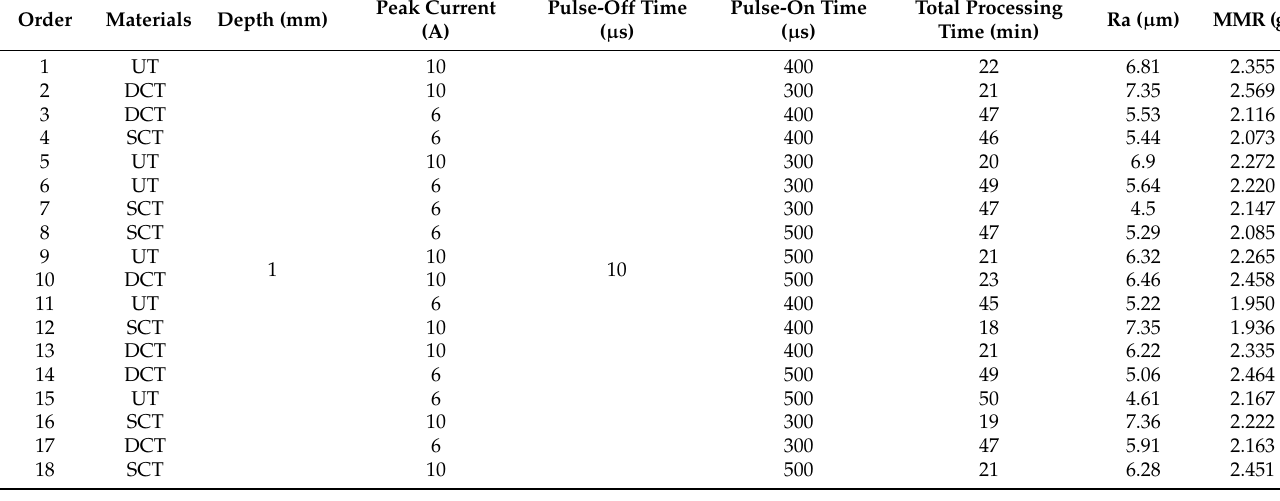
Table 6. Parameters used in experimental work and experimental results.